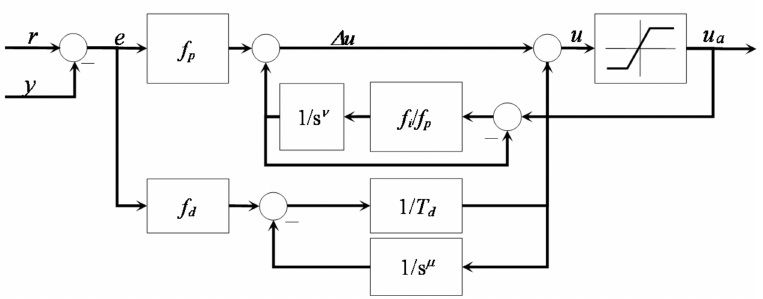
Figure 11. Automatic reset configuration with separated integrators and anti-windup strategy.